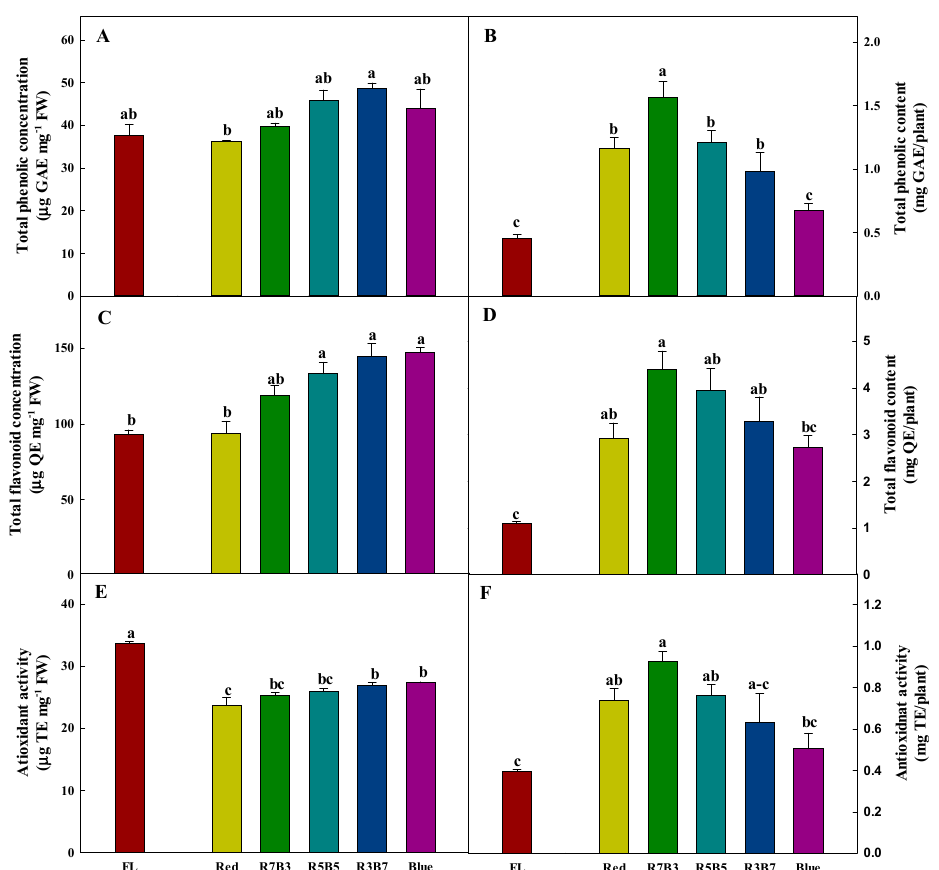
Figure 6. Total phenolic and total flavonoid concentration, and antioxidant activity, per fresh weight ( A ), ( C ), and ( E ), respectively) and total phenolic and total flavonoid content, and antioxidant activity, per plant ( B ), ( D ), and ( F ), respectively) of Salvia plebeia R. Br. as affected by different light treatments at 35 days after transplanting. Vertical bars represent the standard deviation from the mean ( n = 3). Different letters in the same column indicate significant differences based on Tukey’s multiple range test ( α ≤ 0.05).